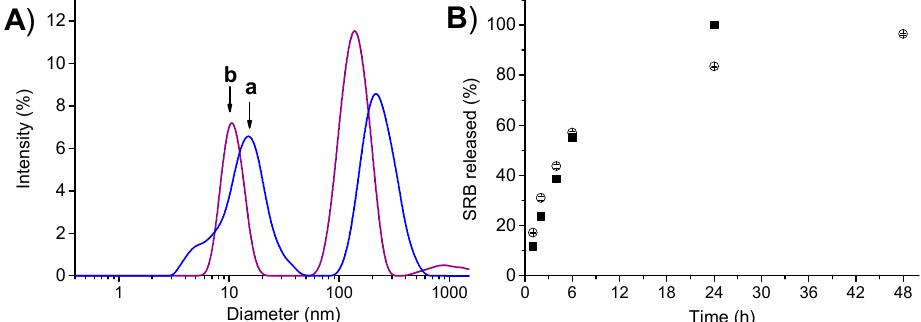
Figure 2. ( A ) Size distribution of PolyCDNO (1 mg mL − 1 ) in the absence (a) and in the presence (b) of SRB (18 μ g mL − 1 ). ( B ) Release profile of SRB (18 μ g mL − 1 ) free ( ) and complexed with PolyCDNO (1 mg mL − 1 ) ( ) assessed by dialysis in PBS at pH 7.4 and 37 °C. Data are reported as the mean ± SD ( n = 3). SD were always lower than 1.65%.